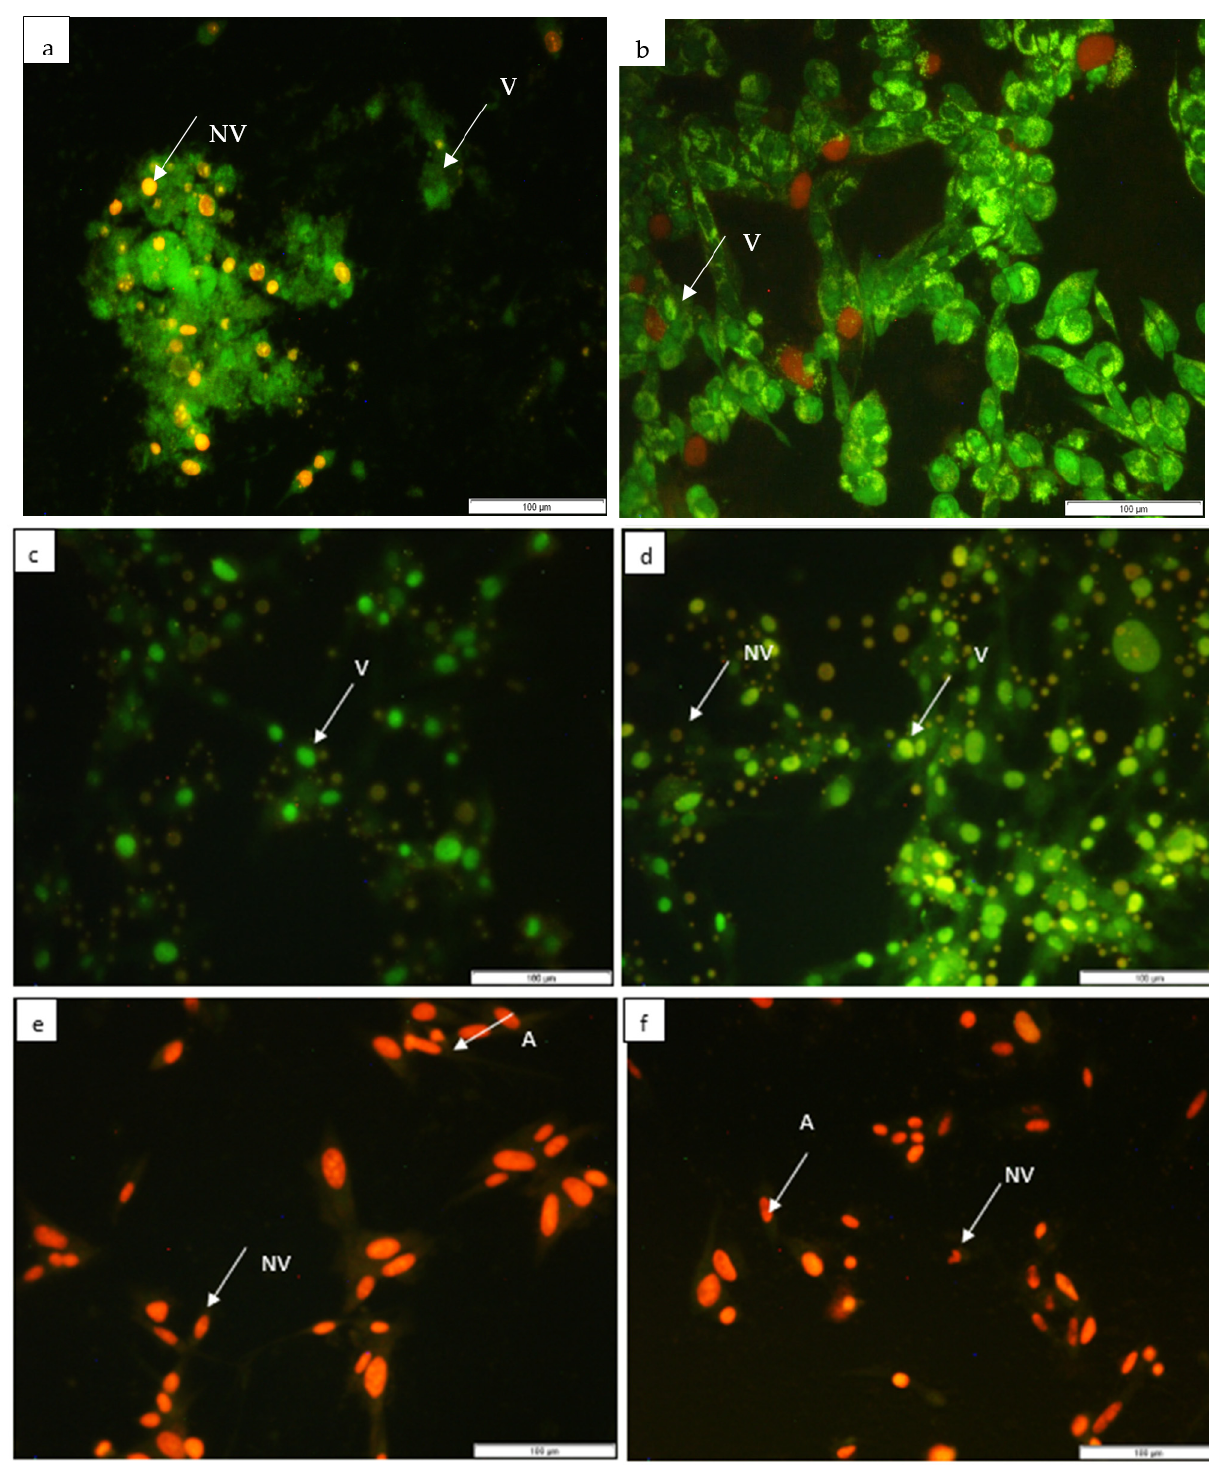
Figure 4. Light micrographs indicating the cell viability of HEK293 cells stained using acridine orange and exposed to the following extracts: ( a ) leaf and ( b ) stembark hexane extract, ( c ) leaf and ( d ) stembark chloroform extract, and ( e ) leaf and ( f ) stembark methanolic extracts of C. erythrophyllum (A—apoptotic cell; V—viable cell; NV—non-viable cell).